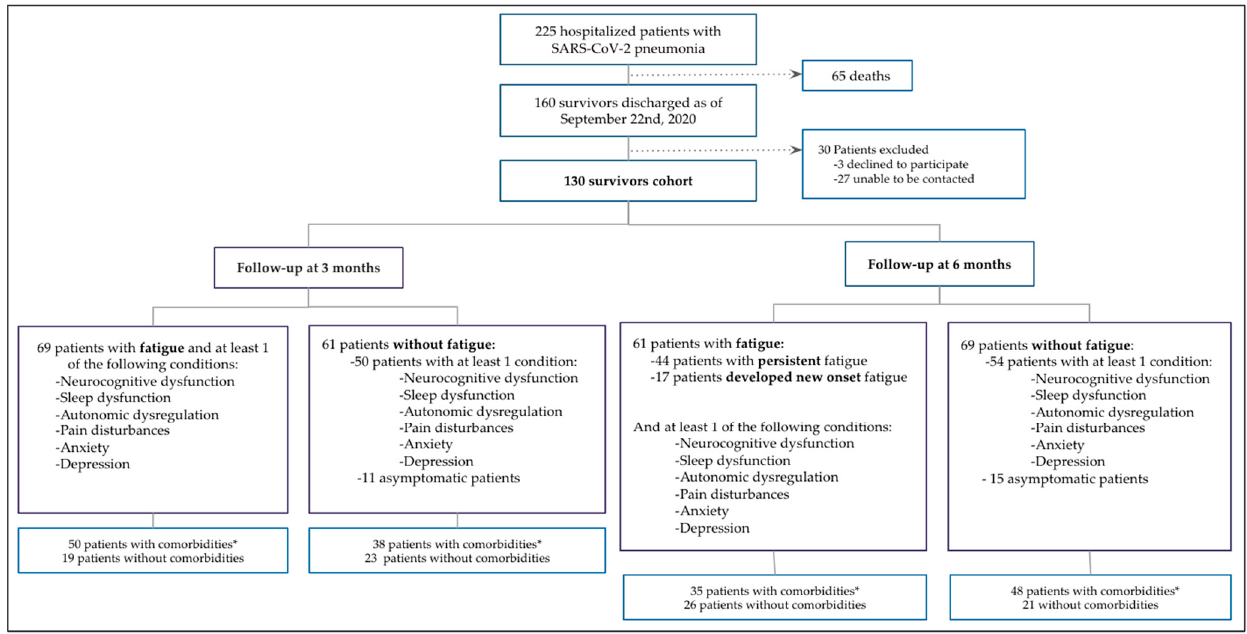
Figure 1. Flow Chart of the Study Design. * Comorbidities: Hypertension, Diabetes, Chronic obstructive pulmonary disease, Chronic Heart disease, Chronic Kidney disease, Immunosuppressive condition or Psychiatric disorder.